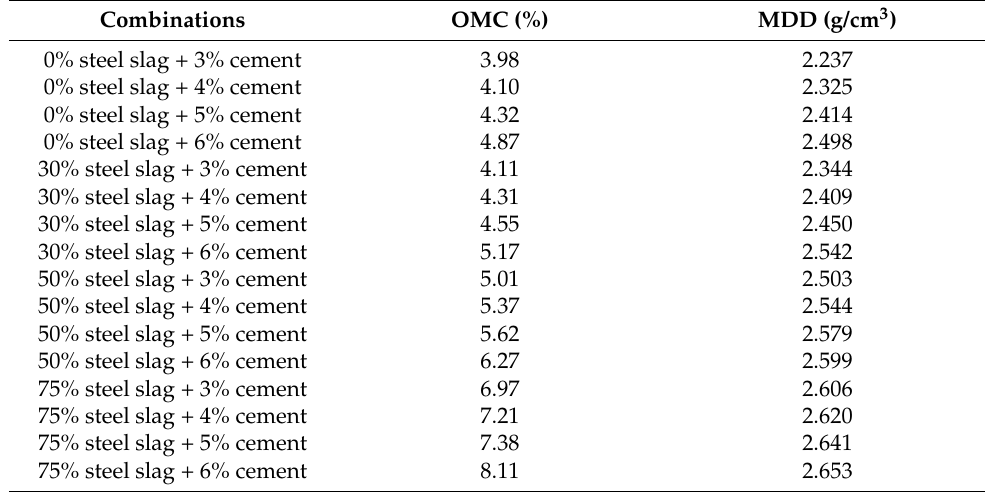
Table 3. OMC and MDD of different steel slag content and cement content.